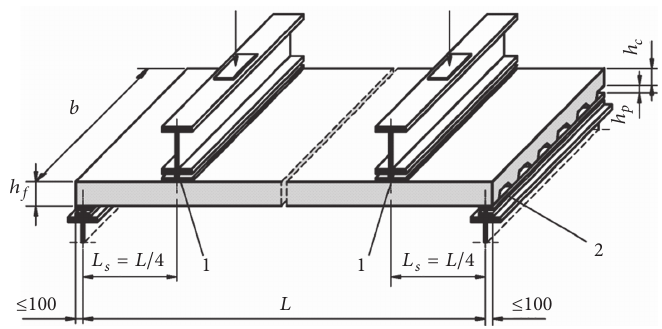
Figure 3: m - k test configuration [5, Annex B]. “1” refers to a neoprene support. “2” refers to a steel plate support.